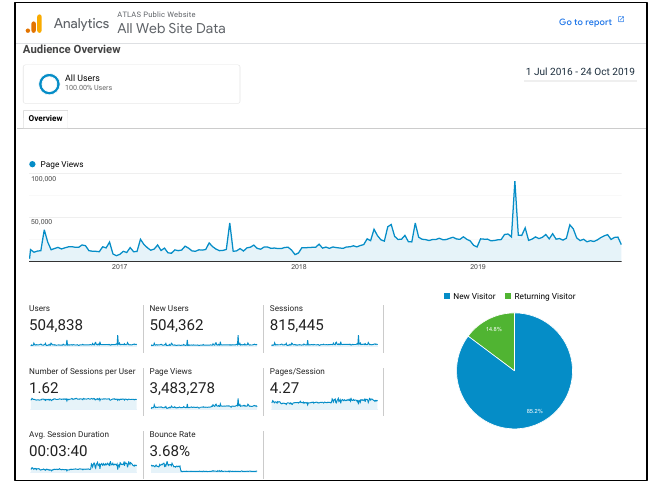
Figure 1. Visit evolution of ATLAS public website in terms of page views /